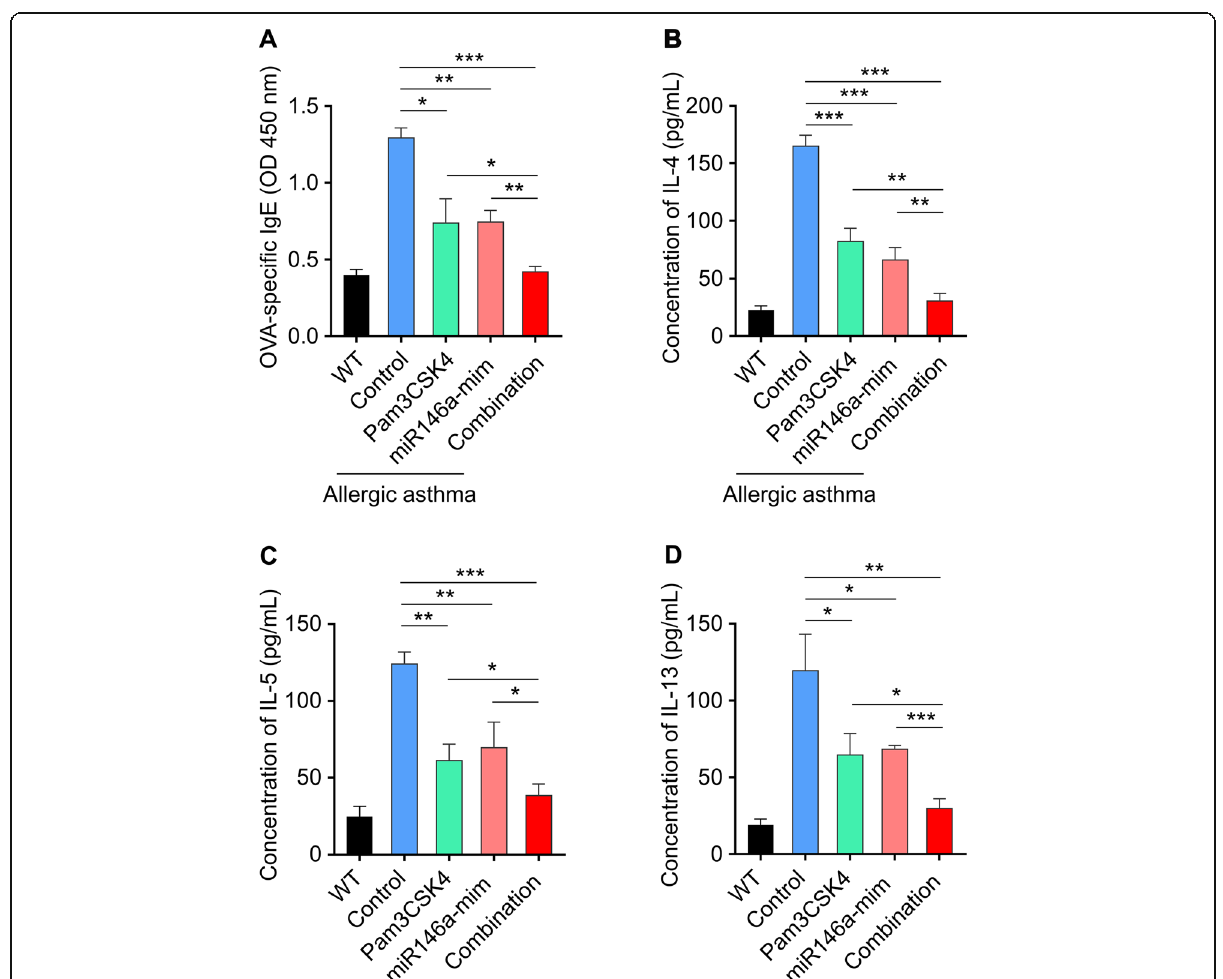
Fig. 5 Simultaneous administration of TLR2 agonist and miR146a mimics attenuates OVA-induced allergic asthma by increasing Th2 cytokines. The levels of OVA-specific IgE in serum ( a ), IL-4 ( b ), IL-5 ( c ), and IL-13 ( d ) in BALF. Serum and BALF were collected 24 h after the last challenge. The levels of OVA-specific IgE and these cytokines were quantified by ELISA. Data represent means ± SD. WT, wide type mice without OVA- induced allergic asthma. n = 6, * p < 0.05, ** p < 0.005, *** p <